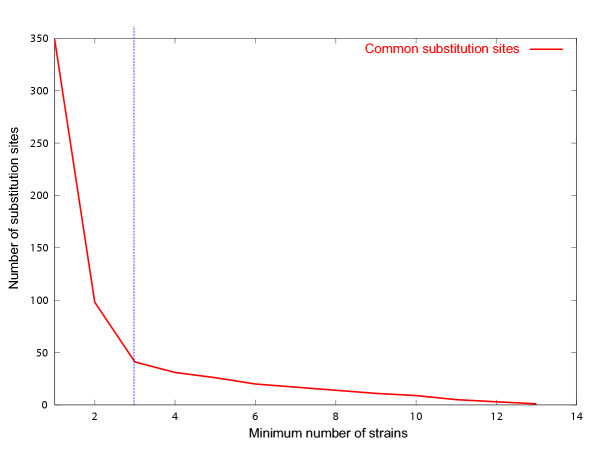
Effects of applying mutation filter to number of substitutions observed. To exclude nucleotide variations arising from sequencing error or other artifacts, we include only variations that are present in at least a number of different isolates. The graph shows an exponential decrease in the number of nucleotide variations detected with increasing filter stringency. The curve essentially flattens around 3, which corresponds to the filtering scheme that considers a sequence variation as a real mutation if it is shared by more than two isolates.